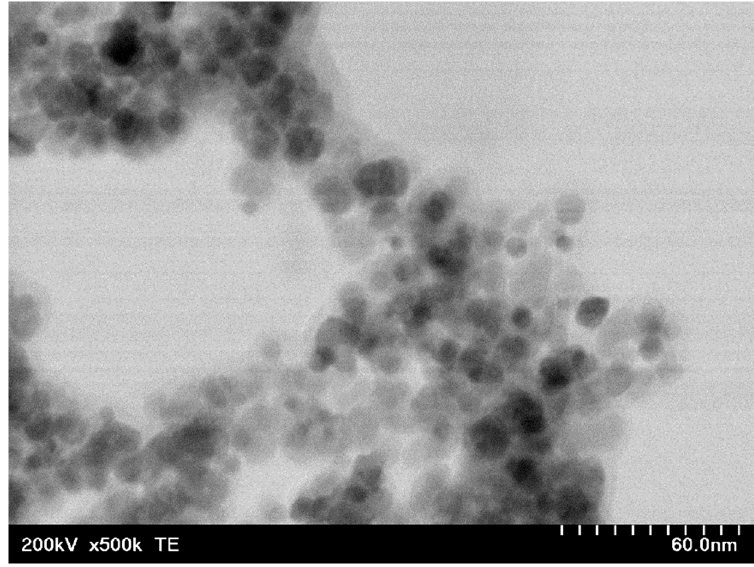
Figure 3. TEM image of iron-oxide nanoparticles (scale bar = 60 nm).